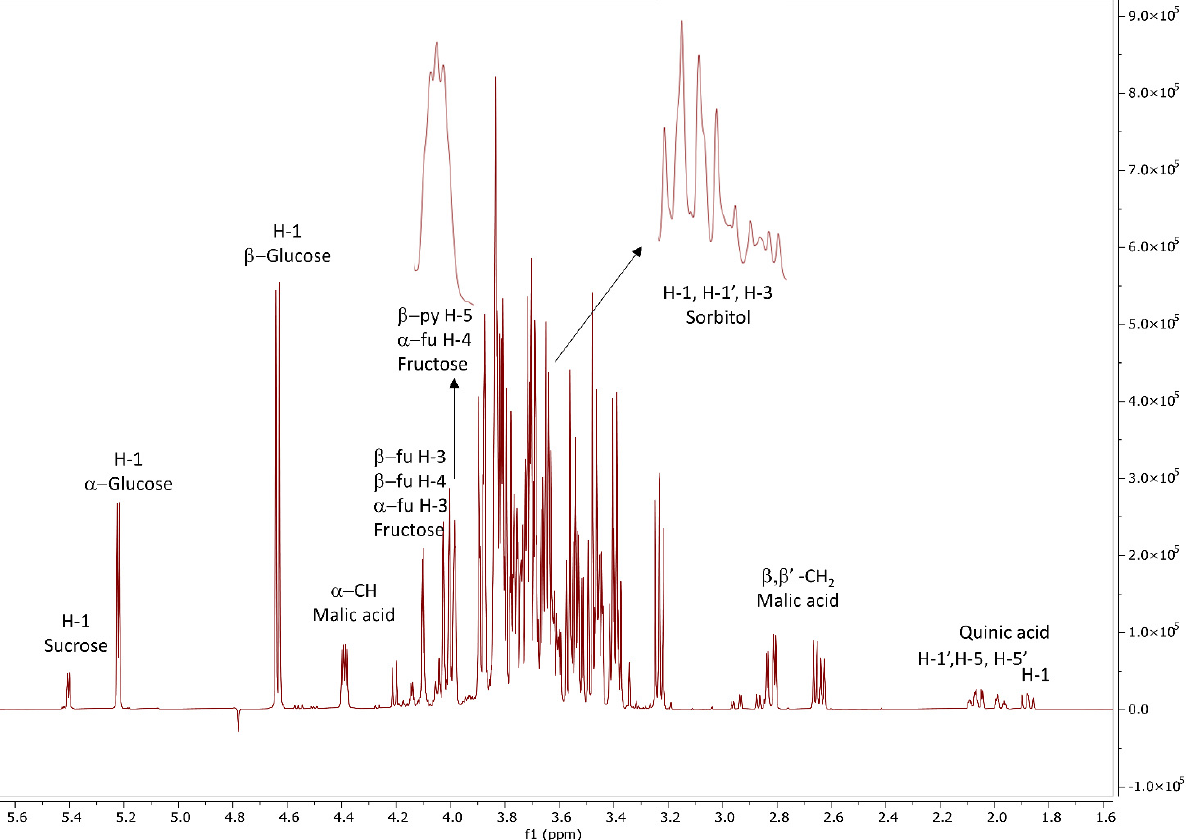
Figure 1. 1 H NMR spectrum of the methanol extract of the fruit skins of the plum cultivar “ Č a č anska